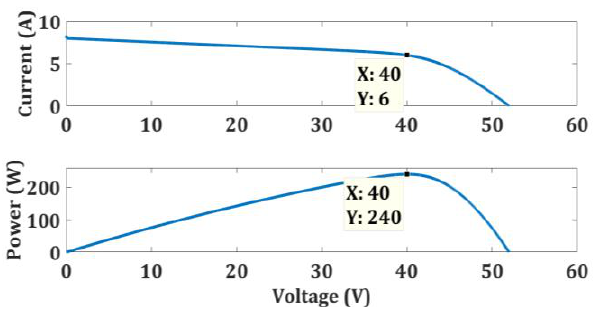
Fig. 8. Characteristic curves of a 4S2P PV string under Zero or